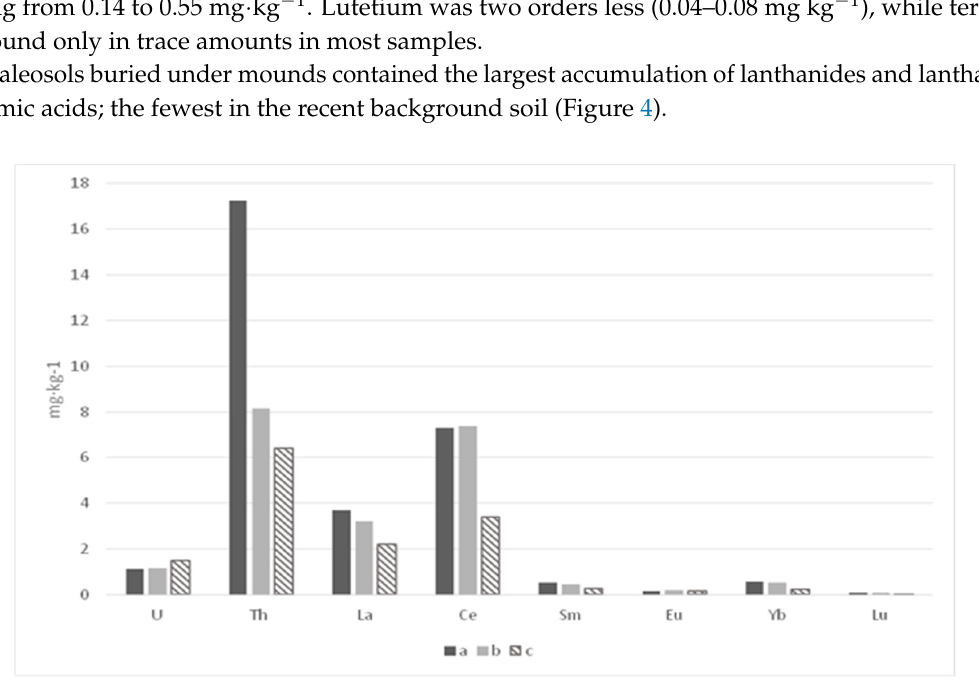
Figure 4. Content of lanthanides, uranium, and thorium in humic acid preparations: ( a ) paleosols under barrows; ( b ) paleosols of settlement; ( c ) recent background soils.